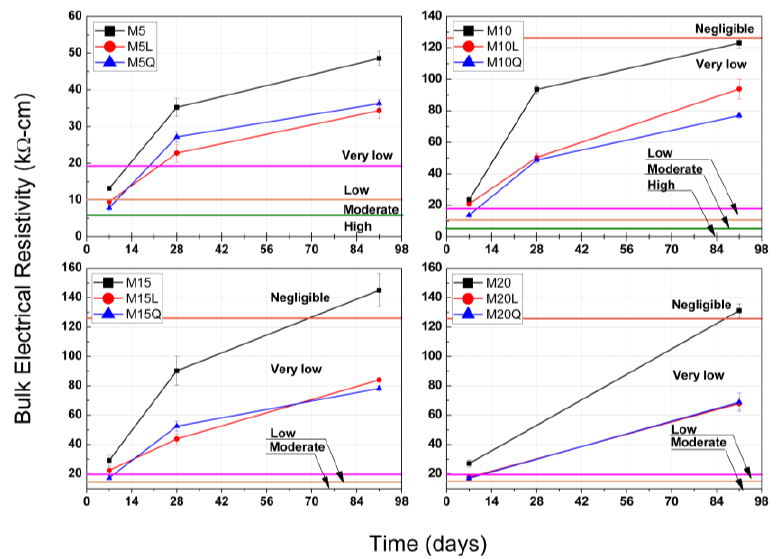
Figure 3. Bulk electrical resistivity results at ages between 7 and 91 days for concretes with metakaolin (M) and limestone (L) or quartz (Q) powders. A qualitative indication of the probability of chloride ion penetration, calculated for the BER results from those reported in AASHTO T358 is also included.